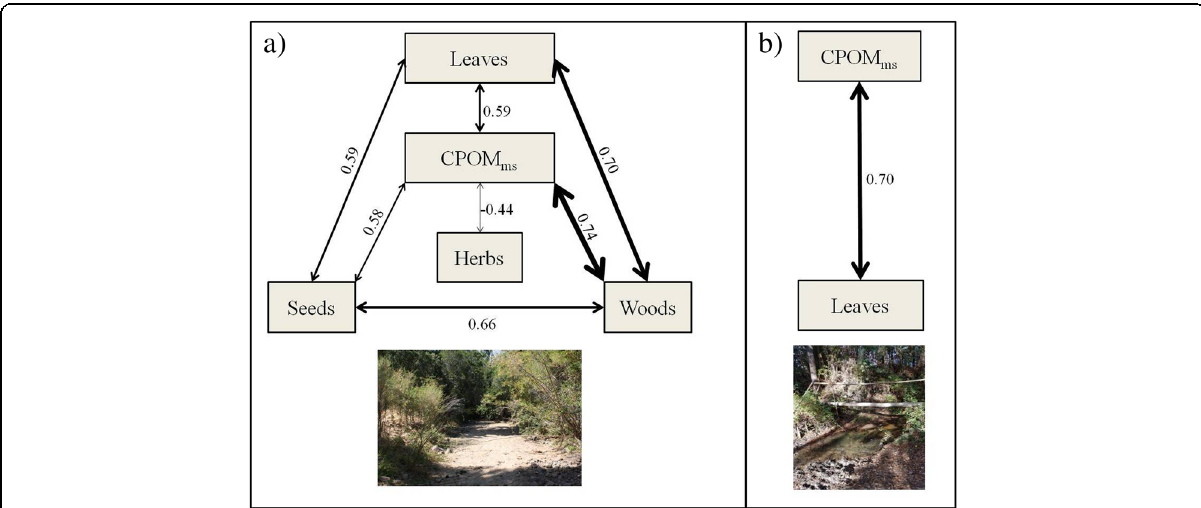
Fig. 4 Relations of the coarse particulate organic matter in intermittent ( a ) and perennial ( b ) rivers. *Arrows and numbers indicate significant relation and r value,